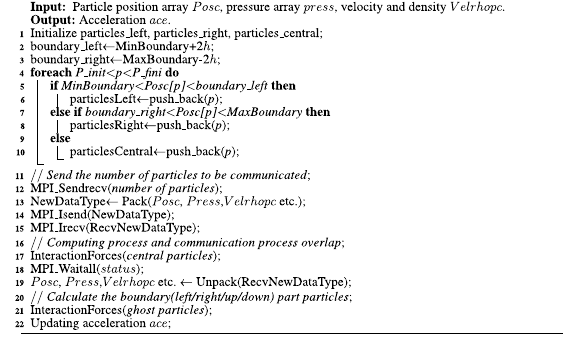
Algorithm 2. parallel particle interaction